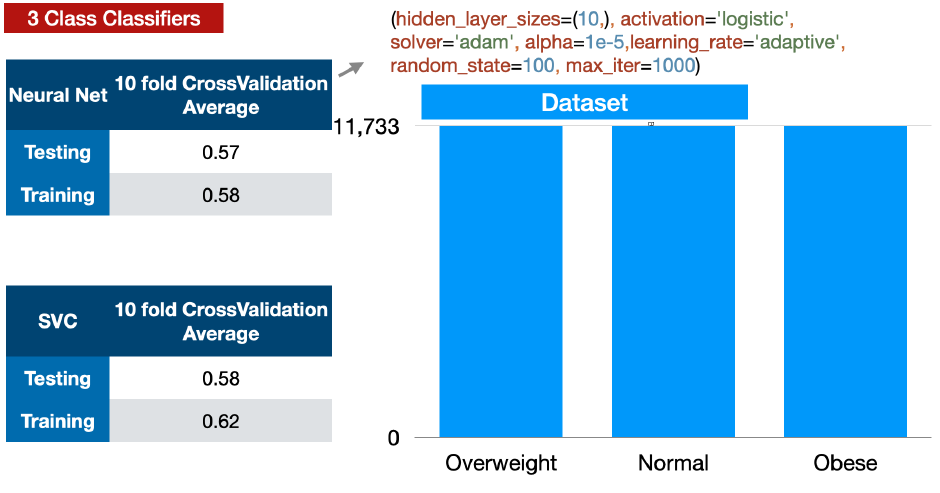
Figure 8. Three-class classifier.